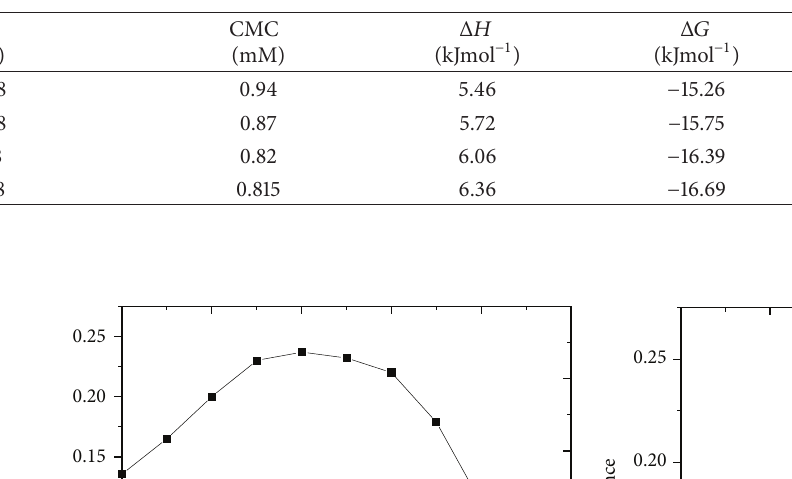
Table 2: The data of critical micelle concentrations (CMC), enthalpy of micellization ( Δ𝐻 ), free energy of micellization ( Δ𝐺 ), entropy of micellization ( Δ𝑆 ), and degree of dissociation ( 𝛽 ) for aqueous solution of CTAB in the presence of reactive red 223 at different temperatures.